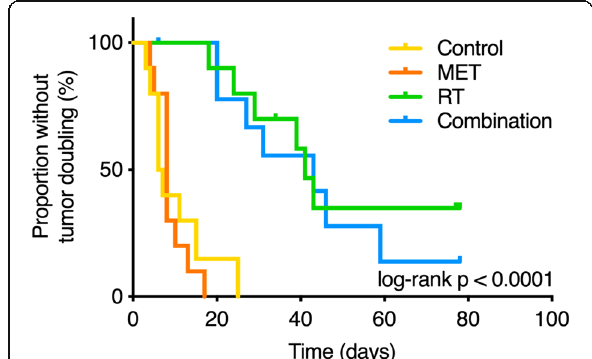
Fig. 3 Kaplan-Meier representation of the proportion of animals without tumor doubling based on therapy regimen (overall log-rank p < 0.0001). MET, metformin; RT, radiotherapy